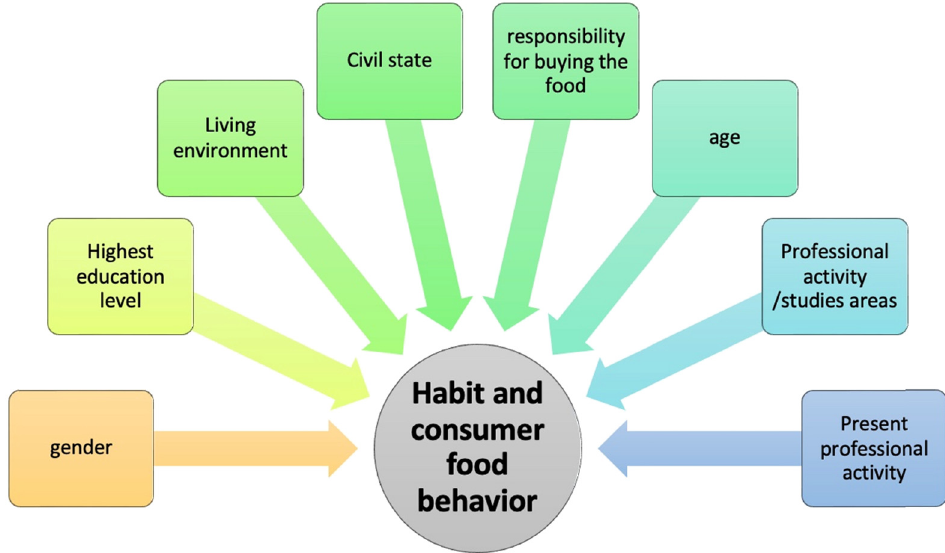
Figure 4: Impact of sociodemographic factors and consumer food behavior